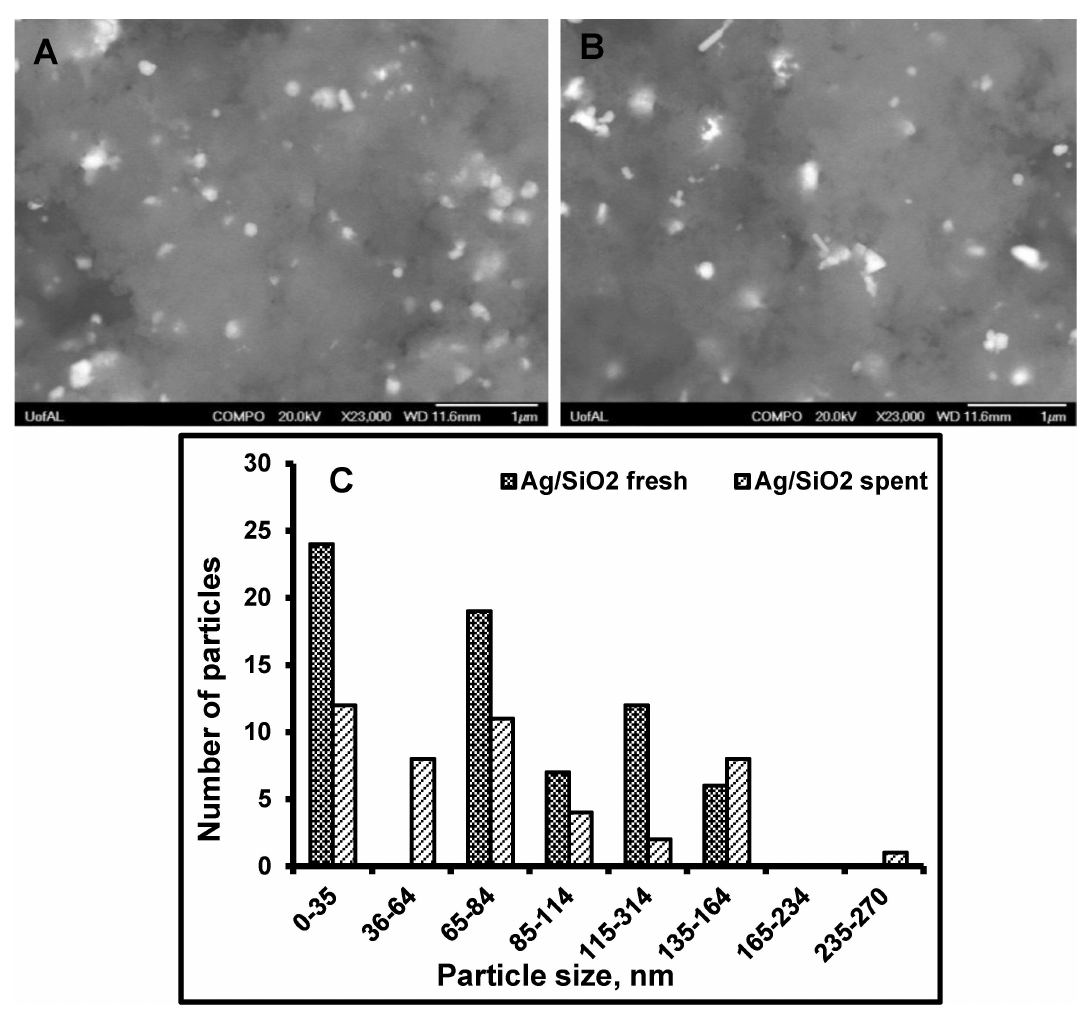
Figure 7. SEM particle size distributions of ( A ) fresh; ( B ) spent Ag/SiO 2 monoliths; ( C ) particle size distribution of fresh and spent Ag/SiO 2